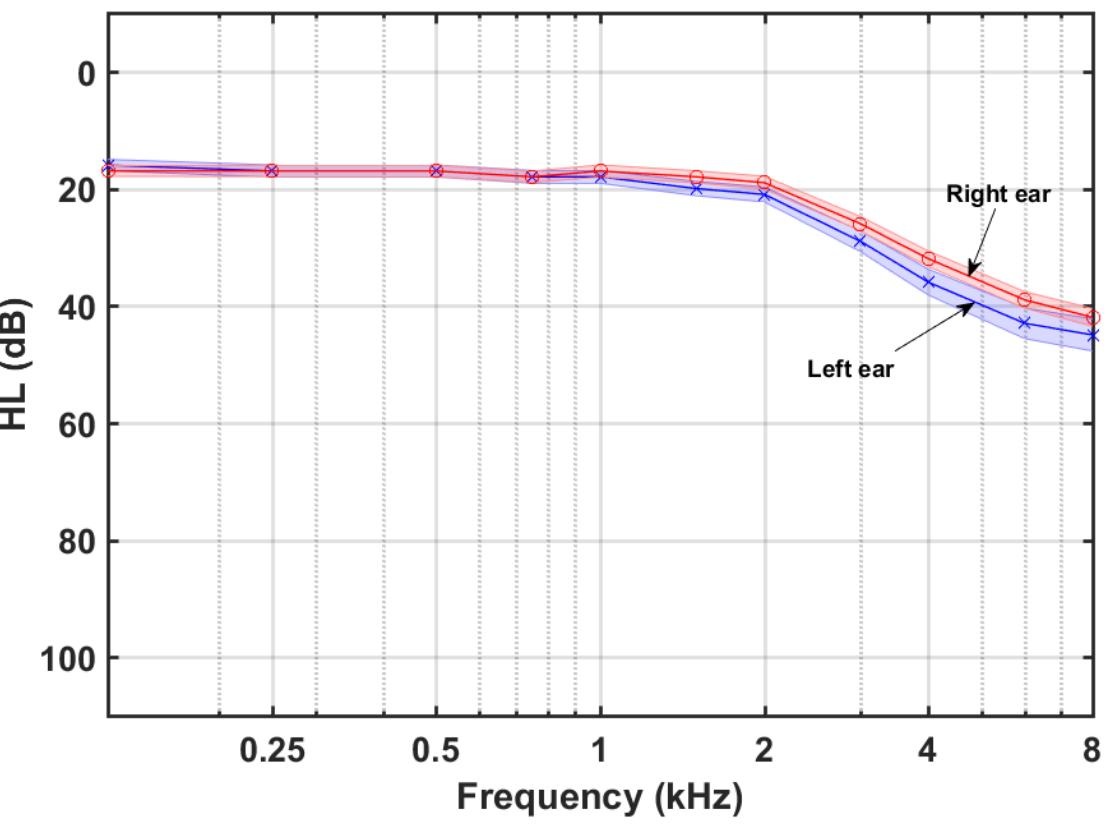
Figure 1. Mean hearing levels of the 270 participants in left and right ears. Shaded area around the HL curves outlines confidence intervals.